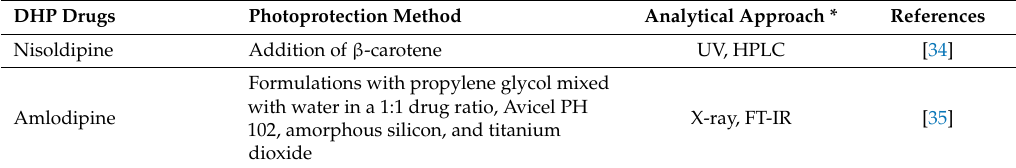
Table 2. Use of light-absorbing